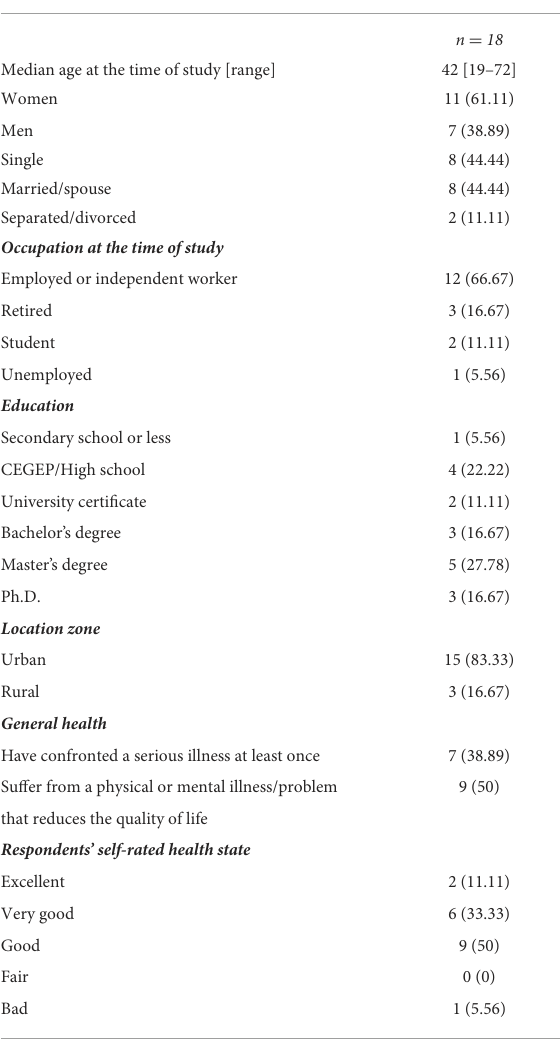
TABLE 1 Descriptive statistics of